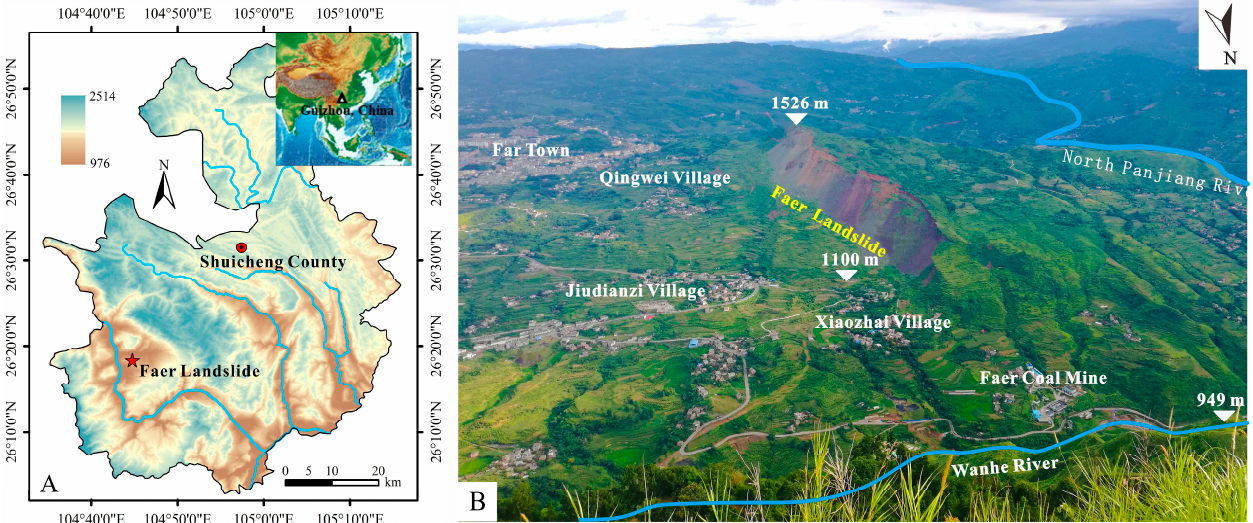
Figure 1. Geological setting: ( A ) the geographical location; ( B ) topography and landforms of the study area.